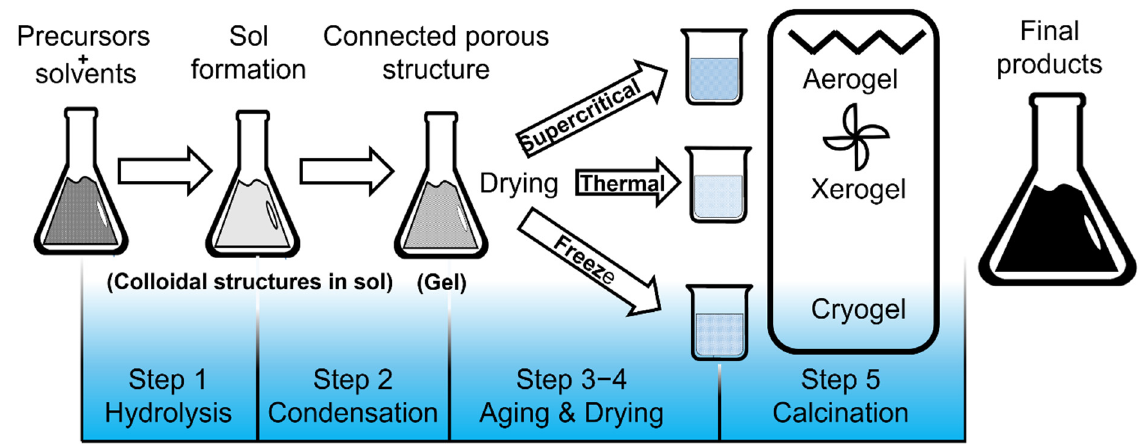
Figure 2. Schematic representation of step-by-step Sol-Gel method.